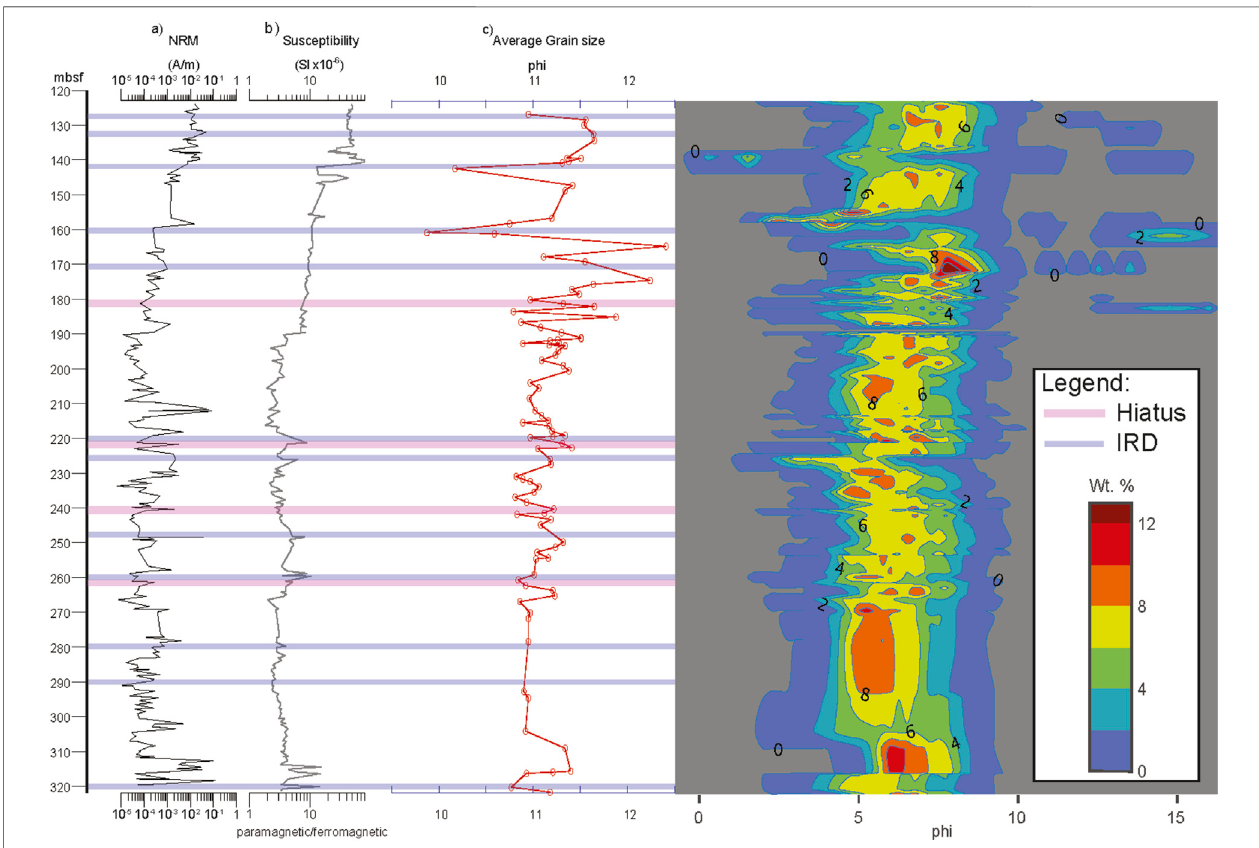
FIGURE 2 | Downcore variations of (A) NRM intensity, (B) low- fi eld magnetic susceptibility ( κ ), (C) average grain size and (D) sediment grain size distribution in a contour. Hiatuses and IRD horizons are highlighted as pink and light blue, respectively.